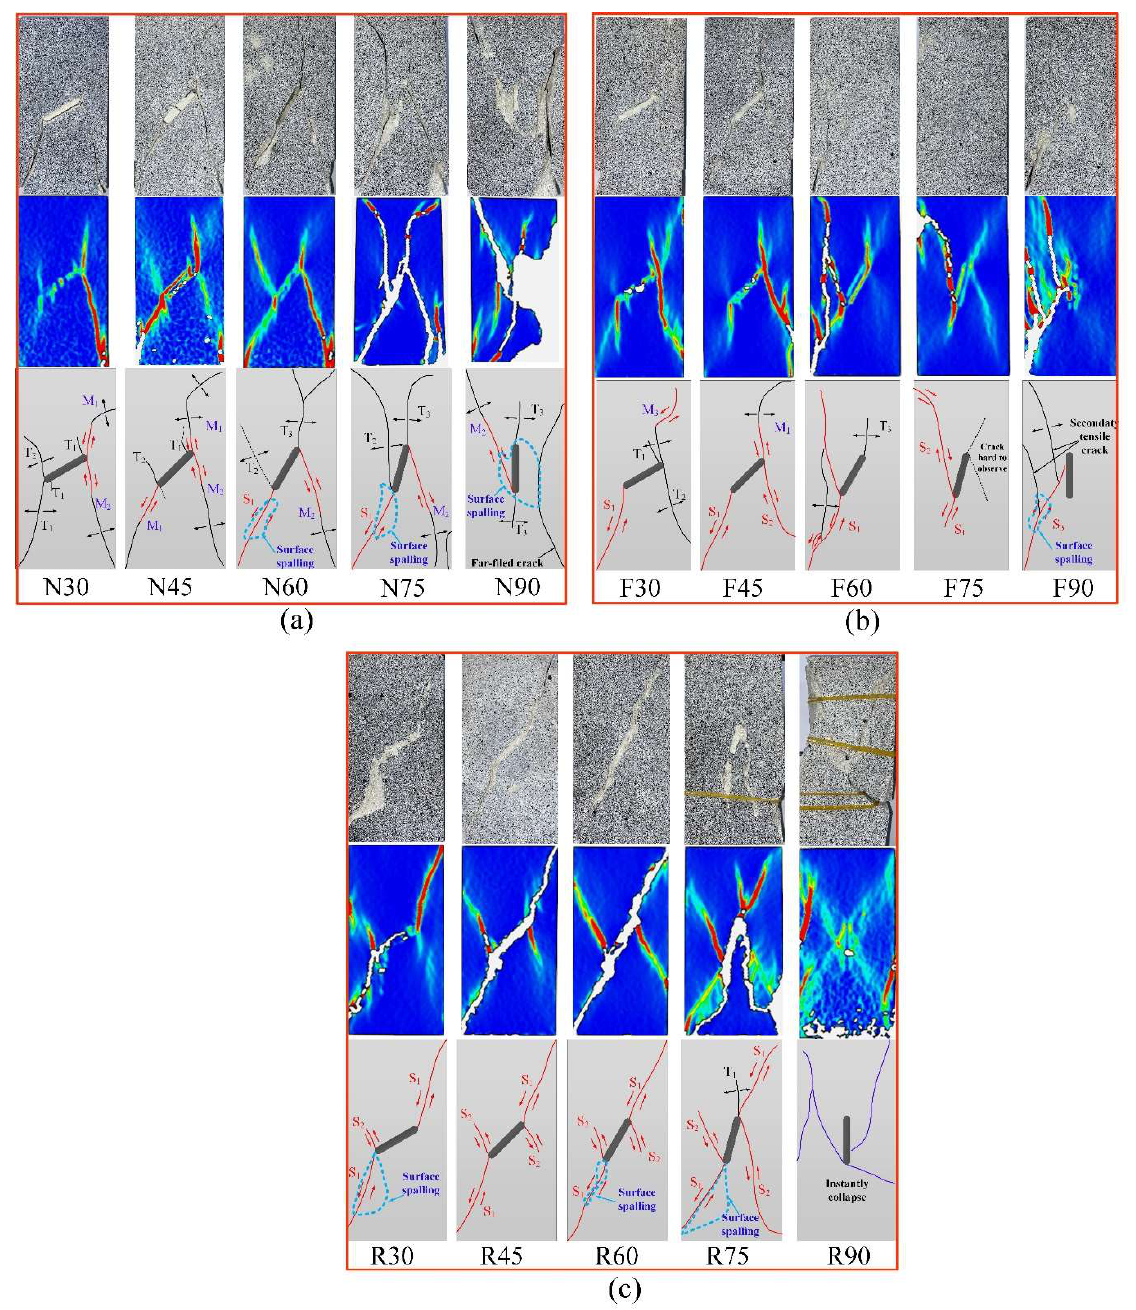
Figure 12. Failure pattern of all samples: ( a ) unanchored samples; ( b ) free-ends anchored samples; ( c ) restrained-ends anchored samples.